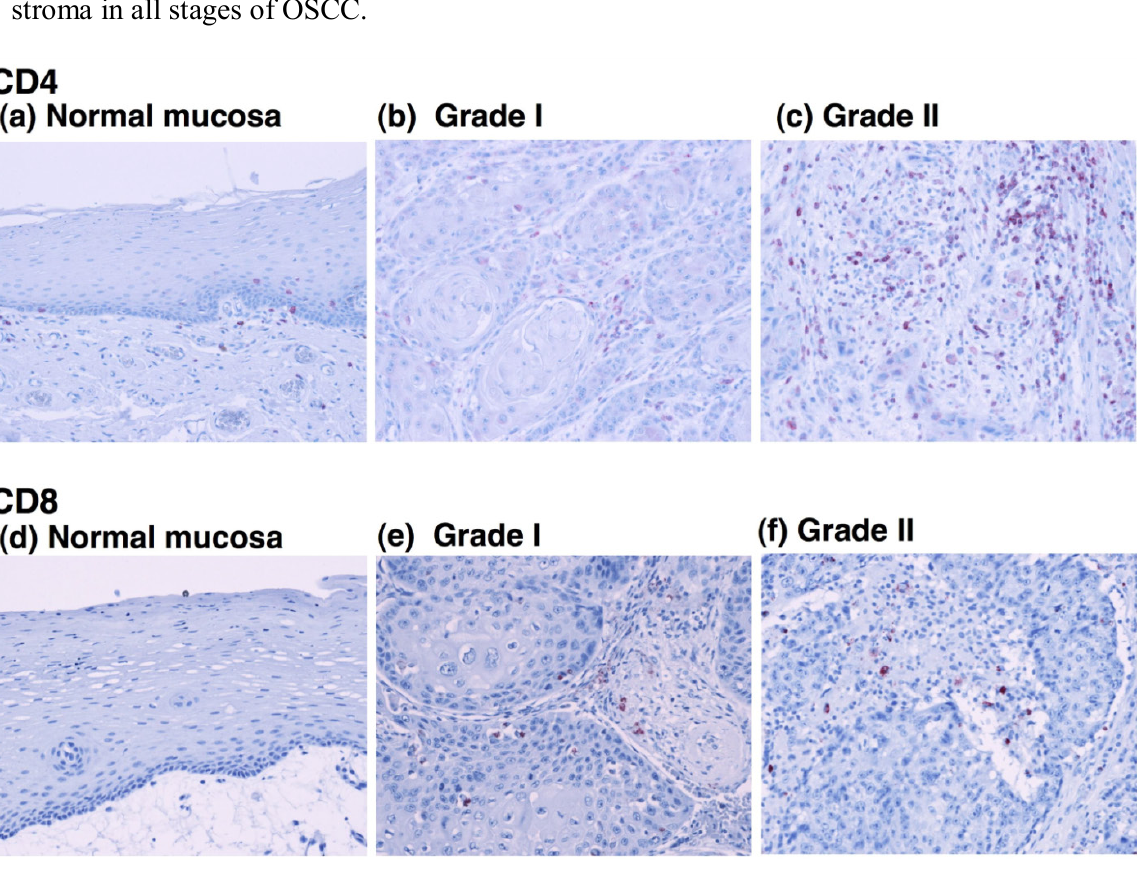
Figure 4. Immunohistochemical staining of OSCC with anti-CD4 and anti-CD8